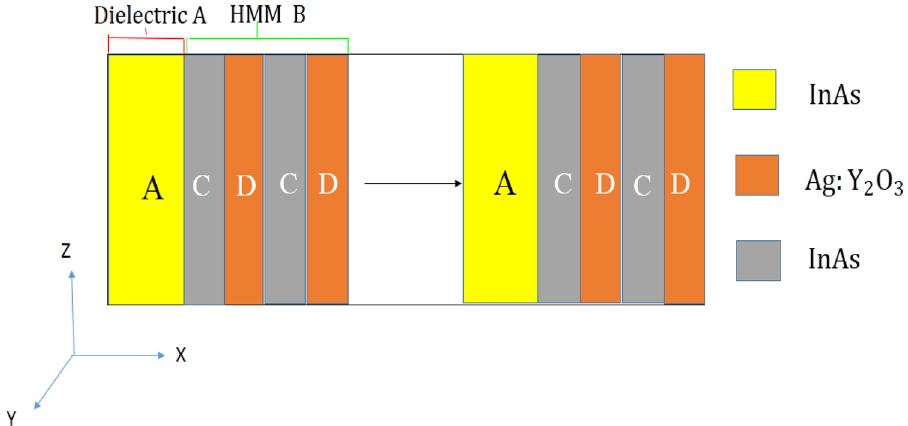
Figure 3. Schematic diagram of PC structure that configured as N =